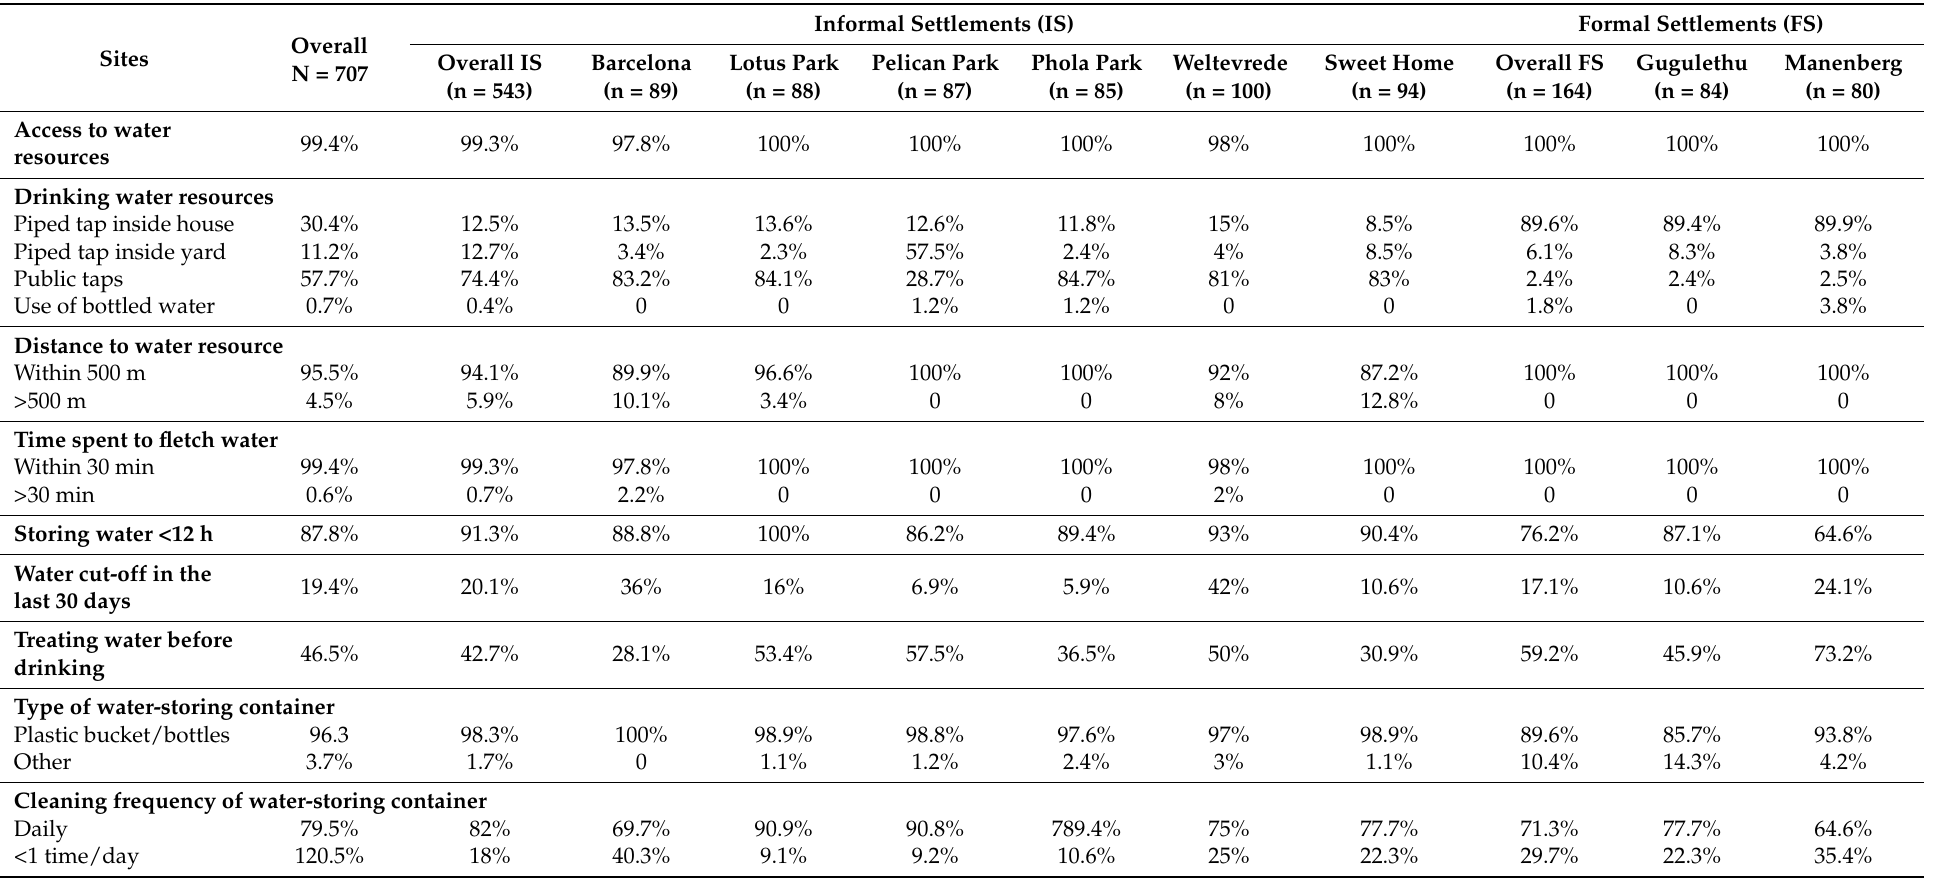
Table 2. Access to water resources of participating households from informal and formal